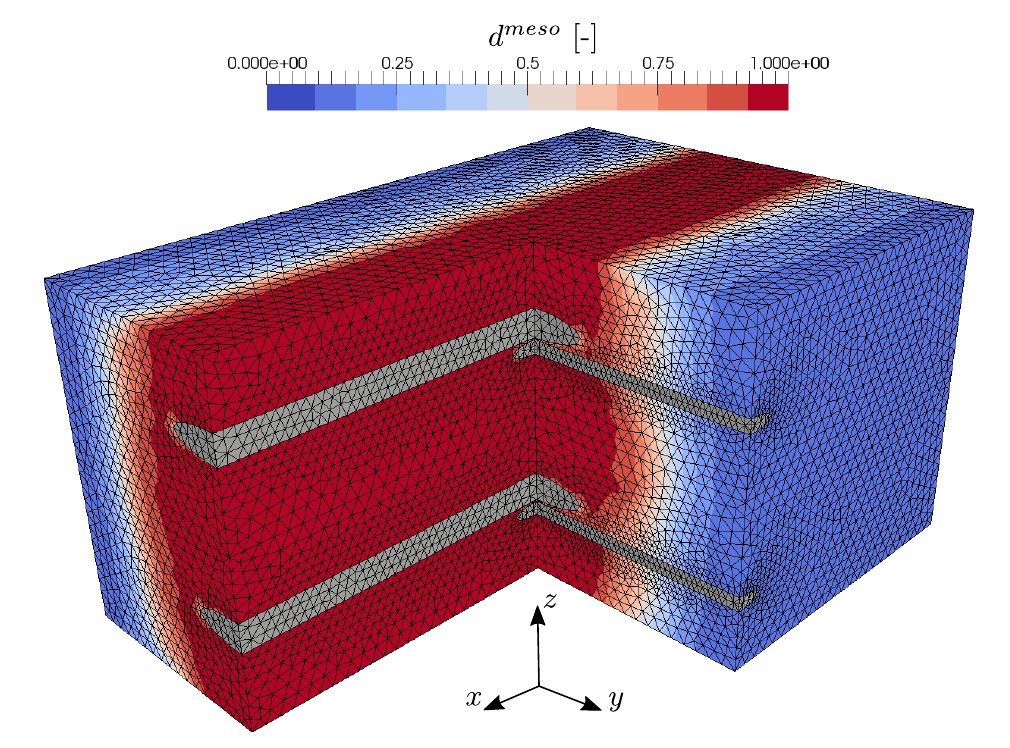
Figure 14. Evolved effective mesoscopic damage distribution due to tensile loading in warp yarn direction with prescribed strain ¯ (cid:101) = [ ¯ (cid:101) xx , ¯ (cid:101) yy = 0, ¯ γ xy = 0 ]